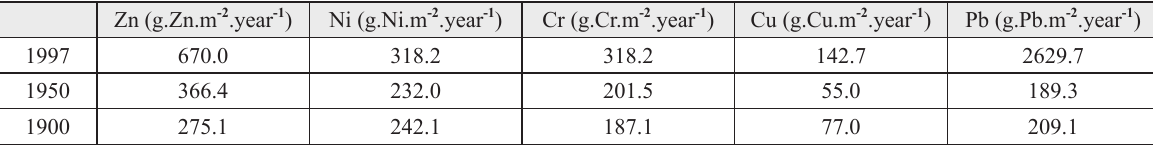
Flux of heavy metal to Guanabara Bay in different